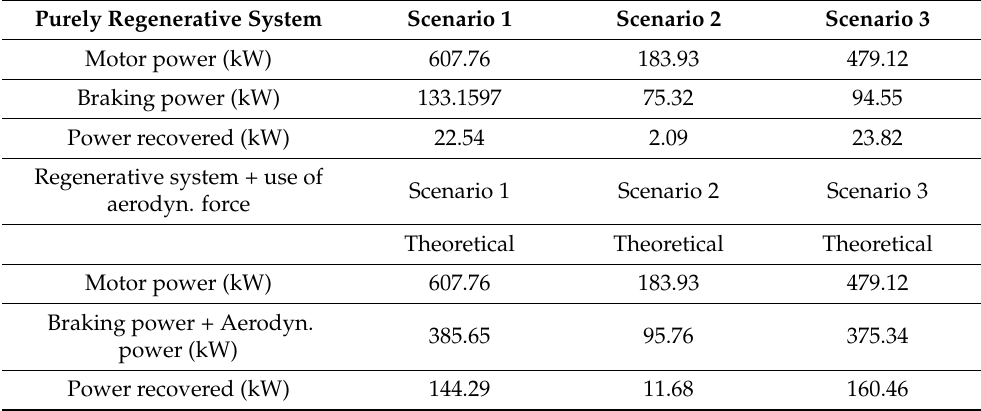
Table 8. Power recovered by 2 turbines with R = 0.35 m.